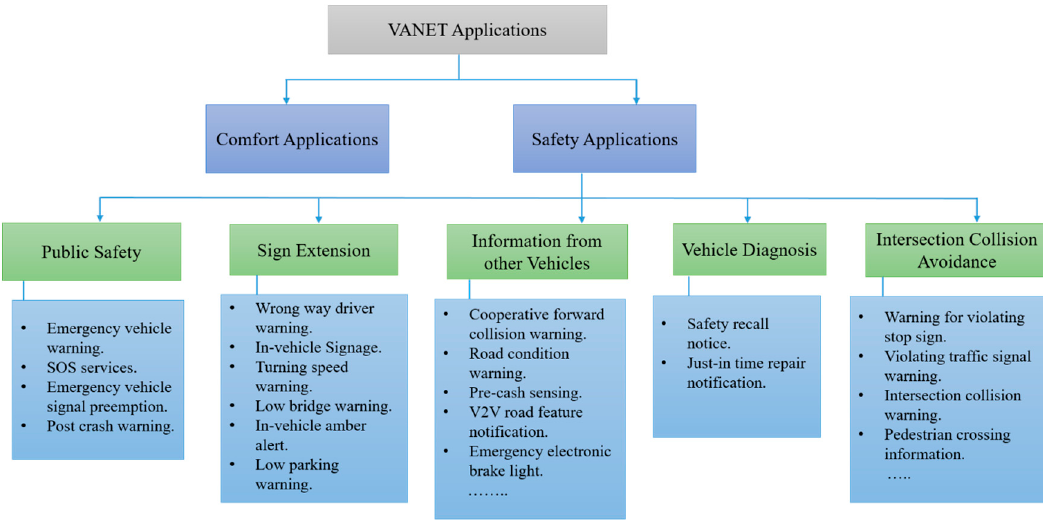
Figure 7. VANET applications.